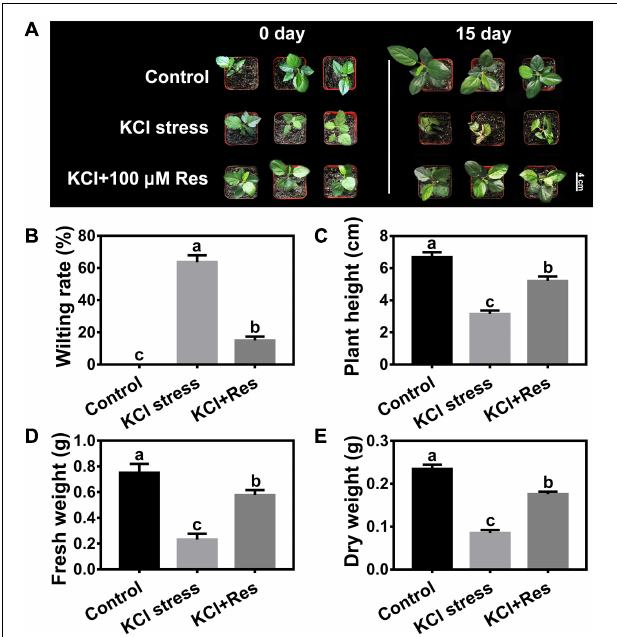
FIGURE 1 | Phenotypes of Malus hupehensis seedlings treated with 50 mM KCl stress and exogenous 100 µ mol Res on day 0 and day 15 (A) . Effect of Res on wilting rate (B) , plant height (C) , fresh weight (D) , and dry weight (E) of apple seedlings after KCl stress for 15 days. The bar (A) represents 4.0 cm. The data represent the mean ± SD of biological replicates. Different lowercase letters indicate significant differences according to Fisher’s least significant difference ( P < 0.05).